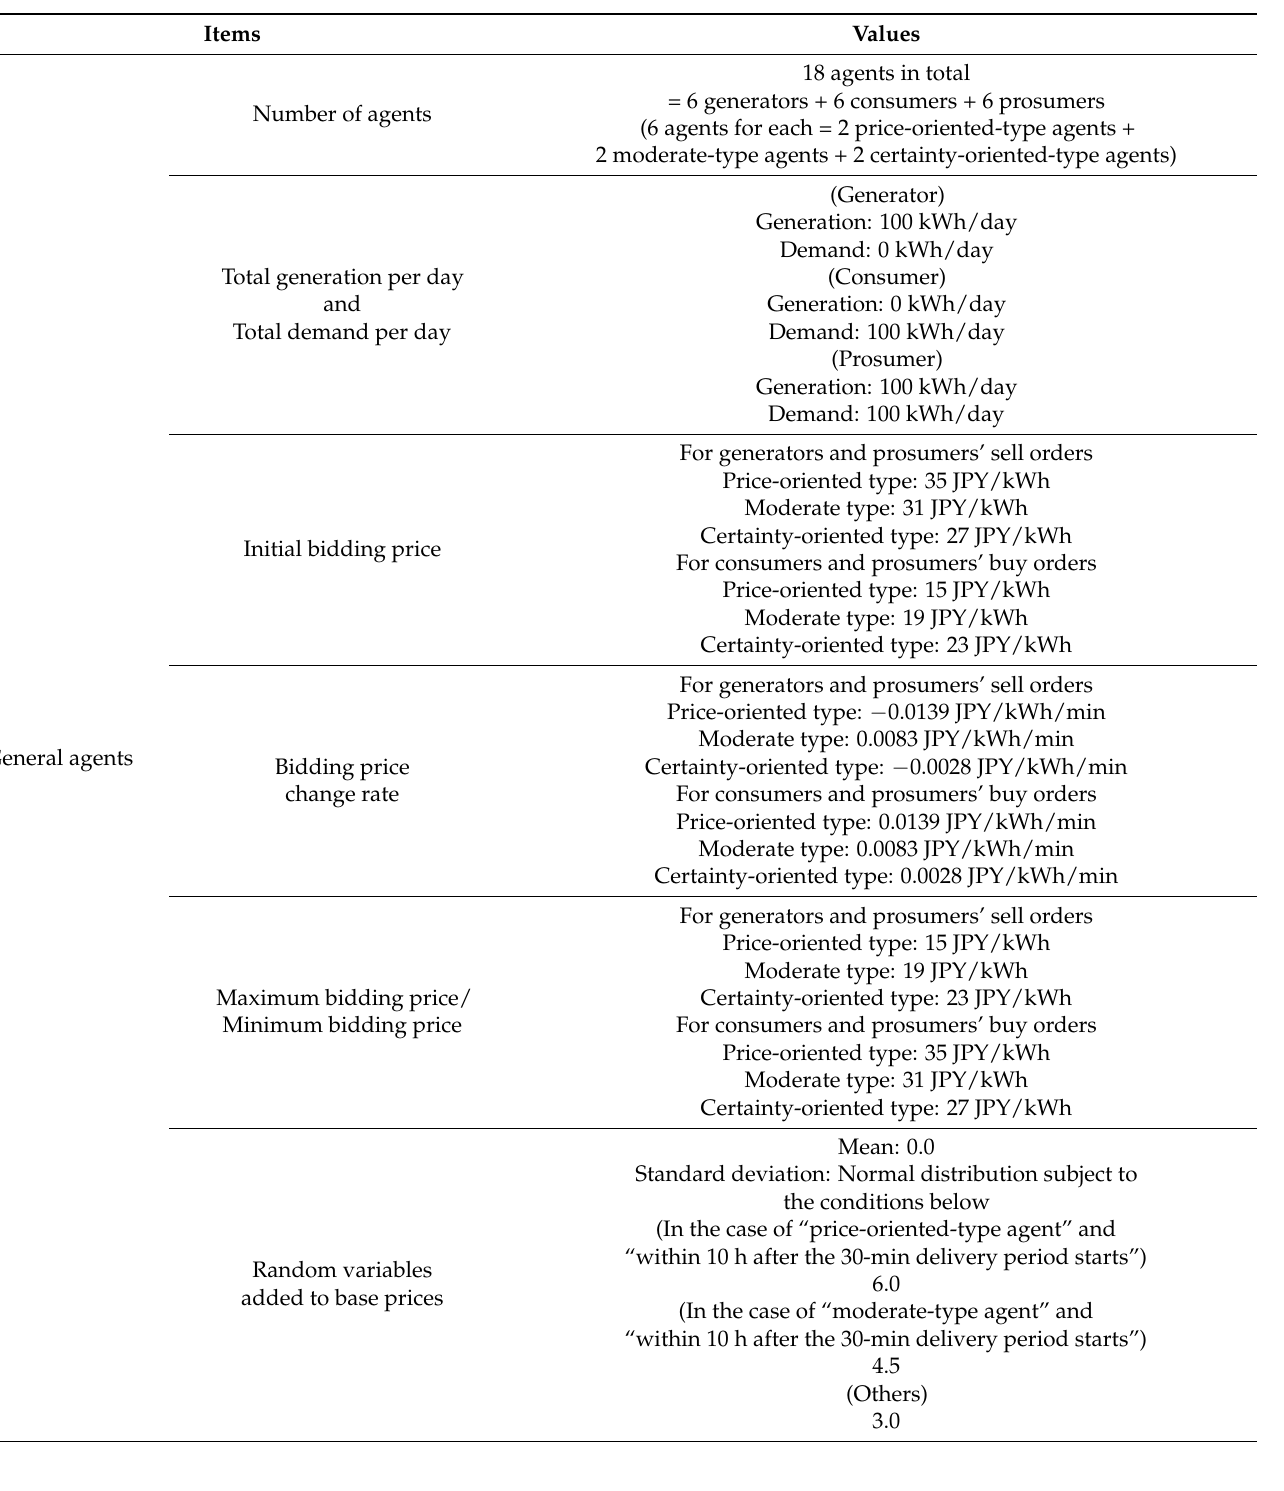
Table 2. Initial parameters in P2P electricity market simulation (see Appendix A for the definitions of the three types of general agents: price-oriented type, moderate type, and certainty-oriented type, and random variables added to base